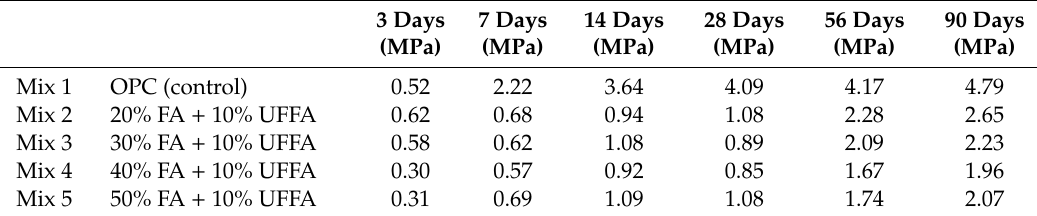
Figure 5. ( a ) Virgin ordinary Portland cement (OPC). ( b ) Concrete microstructure following exposure to a sulphuric acid environment [15]. Table 5. Concrete mass losses in acidic environments [15].